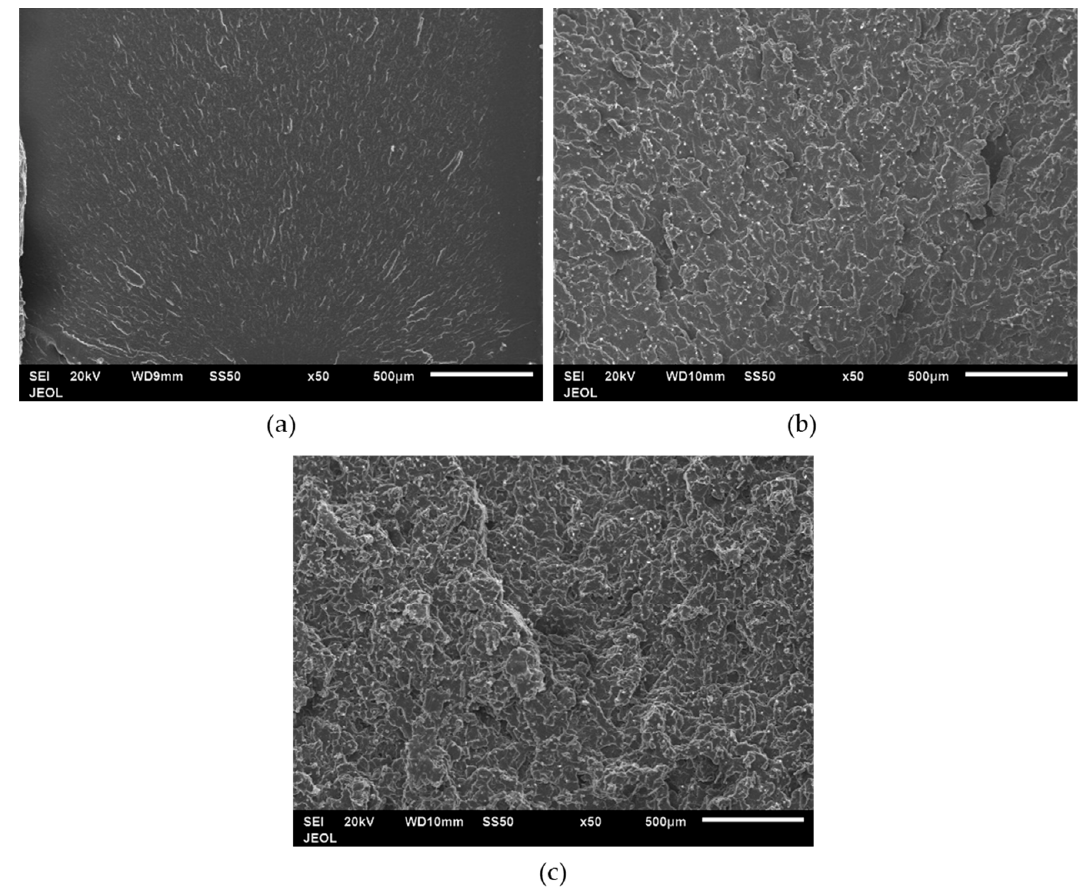
Figure 14. SEM images impact fracture surface of ( a ) neat PP, ( b ) PP/10SCF, and ( c ) PP/20SCF composites.